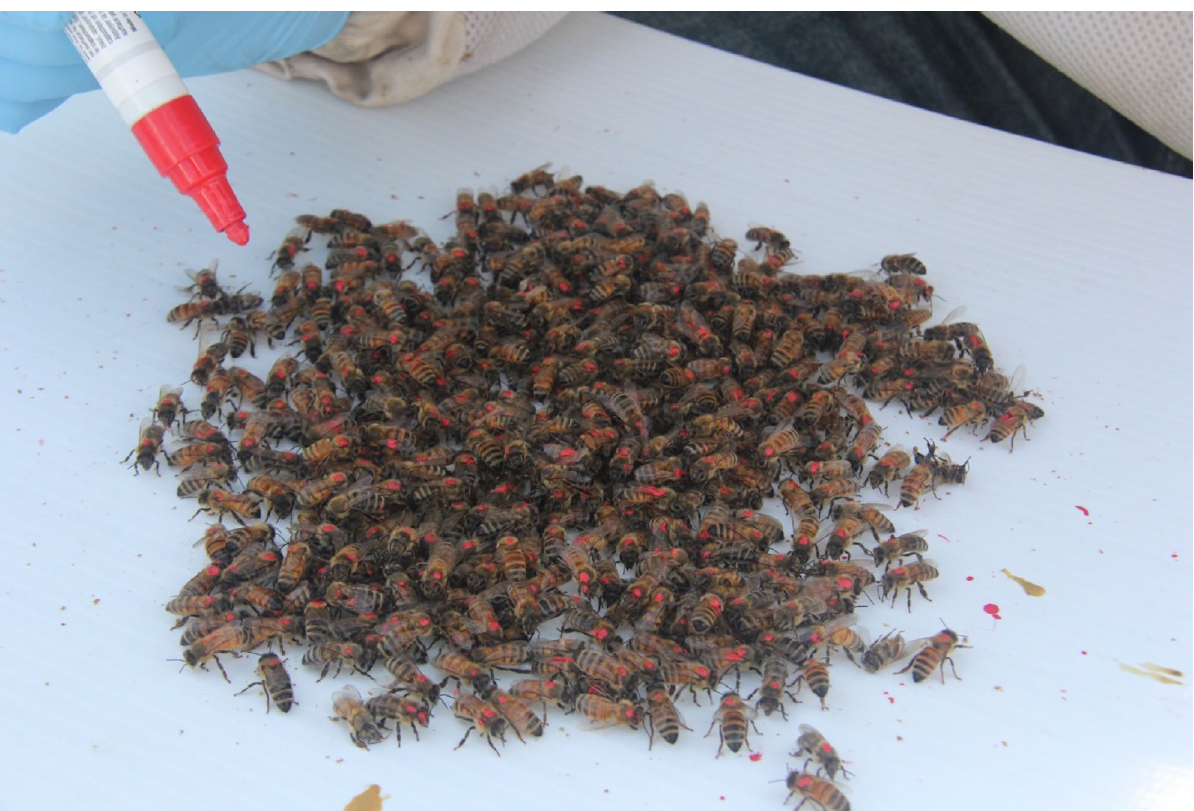
Figure 3. A batch of freshly painted bees on a flat surface. Here IPM sticky boards were